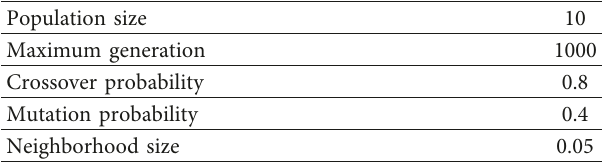
Table 2: Genetic algorithm